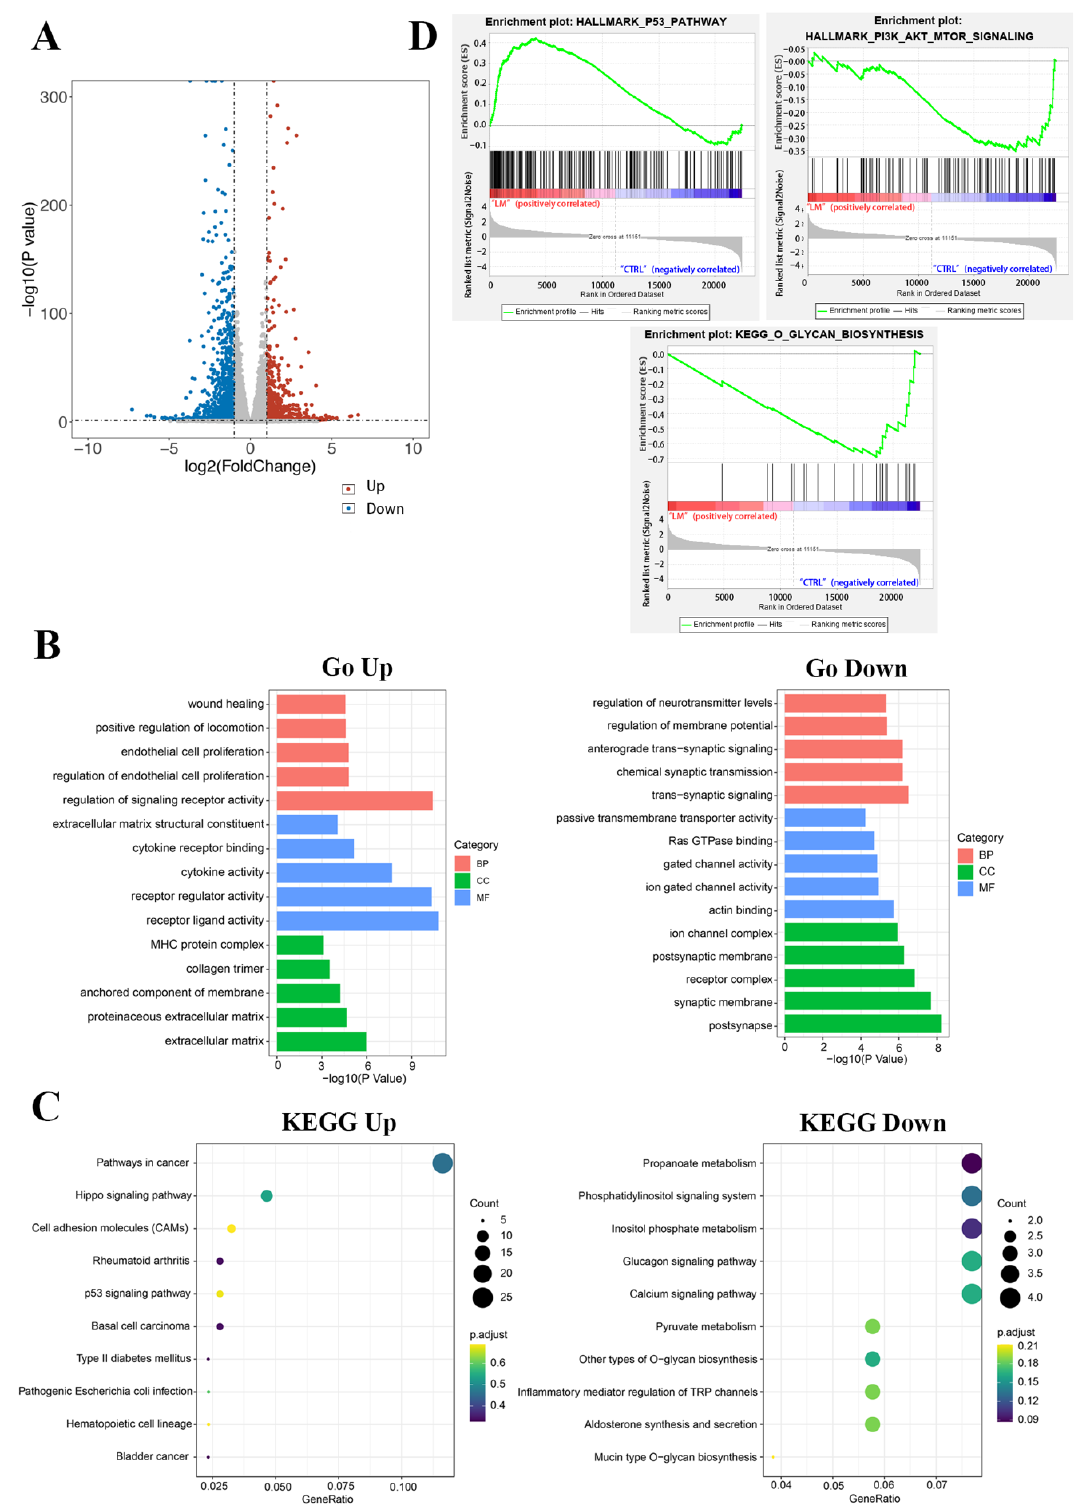
Figure 2. Functional analysis of differential genes. ( A ) Scatter plots of differentially expressed genes. There were 737 up-regulated genes and 1027 down-regulated genes in the LM group. Abscissa is the difference multiple (logarithmic transformation based on 2); ( B ) The gene ontology annotation analysis between DAGs and classification of BP, MF, and CC; ( C ) The KEGG pathway analysis of related DAGs; ( D ) The GSEA results of differentially abundant genes.